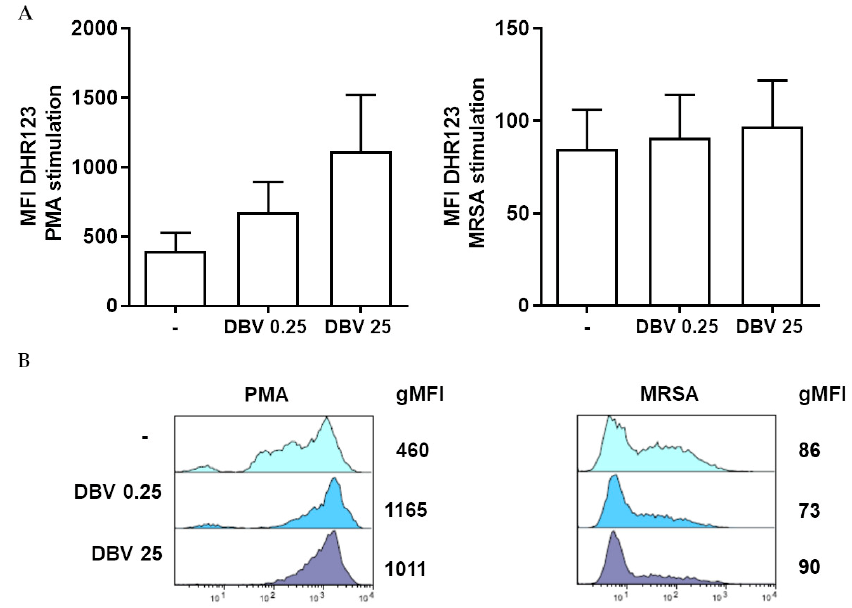
Figure 3. Effect of DBV on ROS production by activated-PMNs. ( A ) PMNs were untreated or treated with DBV at 0.25 and 25 μ g/mL for 60 ′ and then stimulated with PMA (100nM) or MRSA (10:1) for 30 ′ . Cells were loaded with DHR 123, and the intracellular production of ROS was assessed by flow cytometry. The intensity of ROS production (measured as gMFI) is shown. Data show means ± SEM of at least three independent experiments. ( B ) Panels illustrating representative phenotypes displayed by PMNs exposed to PMA (left panel) or to MRSA (right panel), based on DHR 123 fluorescence expression. gMFI values are shown on the right side of each panel.